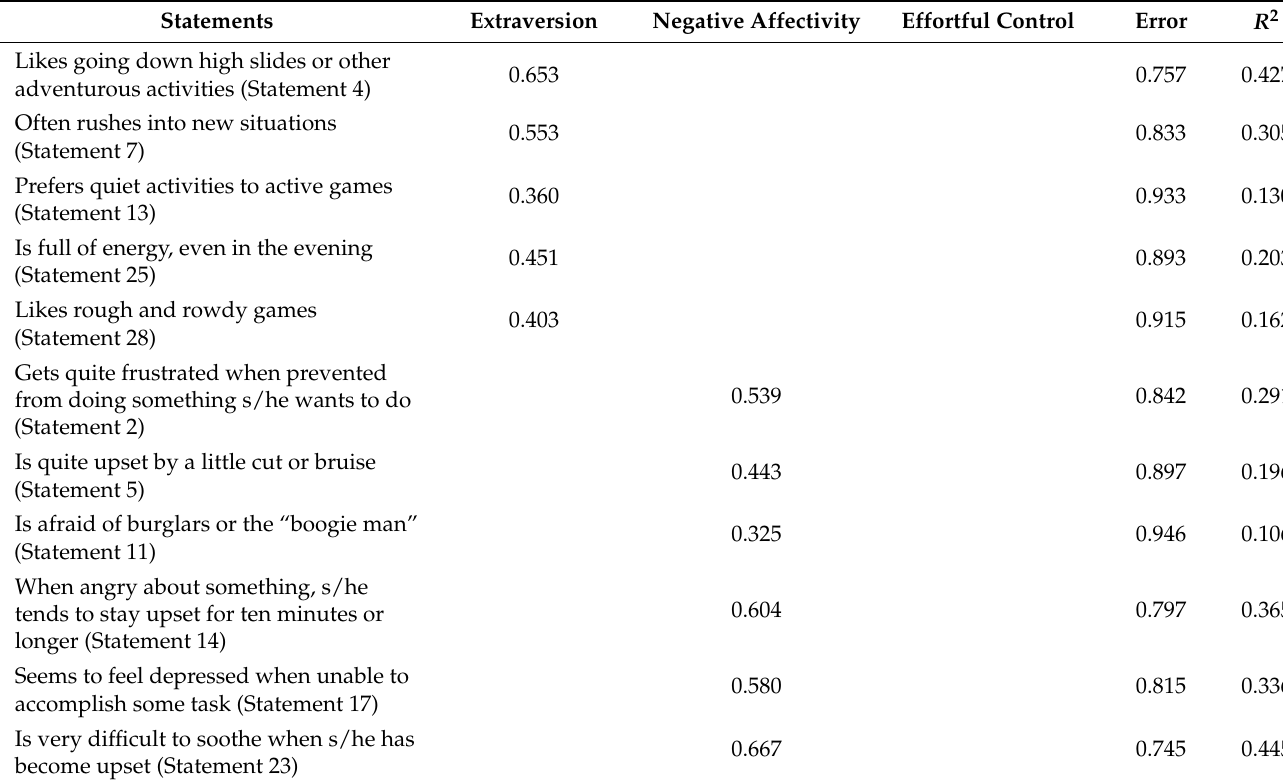
Table 2. The structure of the revised Children’s Behavior Questionnaire—Very Short Form (CBQ—VSF) (standardized